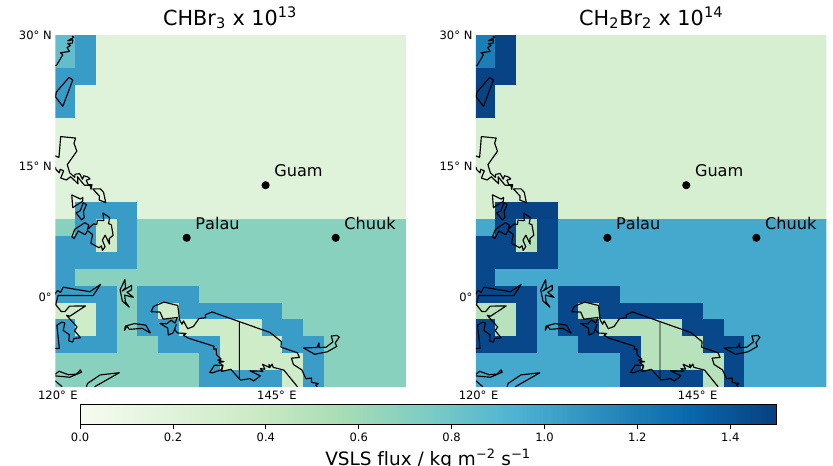
Figure 2. Surface emissions of CHBr 3 (10 13 kgm − 2 s − 1 ) and CH 2 Br 2 (10 14 kgm − 2 s − 1 ) taken from Liang et al. (2010) for the time and study domain of the CAST and CONTRAST campaigns.